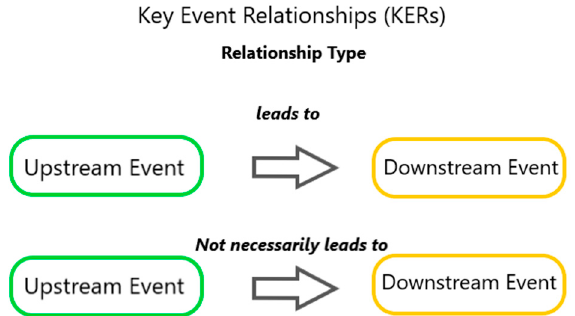
Figure 2. Some of the types of Key Event Relationships (KERs), showing the possible and theoretical relationships between an upstream key event and a downstream key event. Along with the AOP, the essentiality assessment could be used to identify biomarkers of effect or exposure useful to prevent or modify adverse pathways.